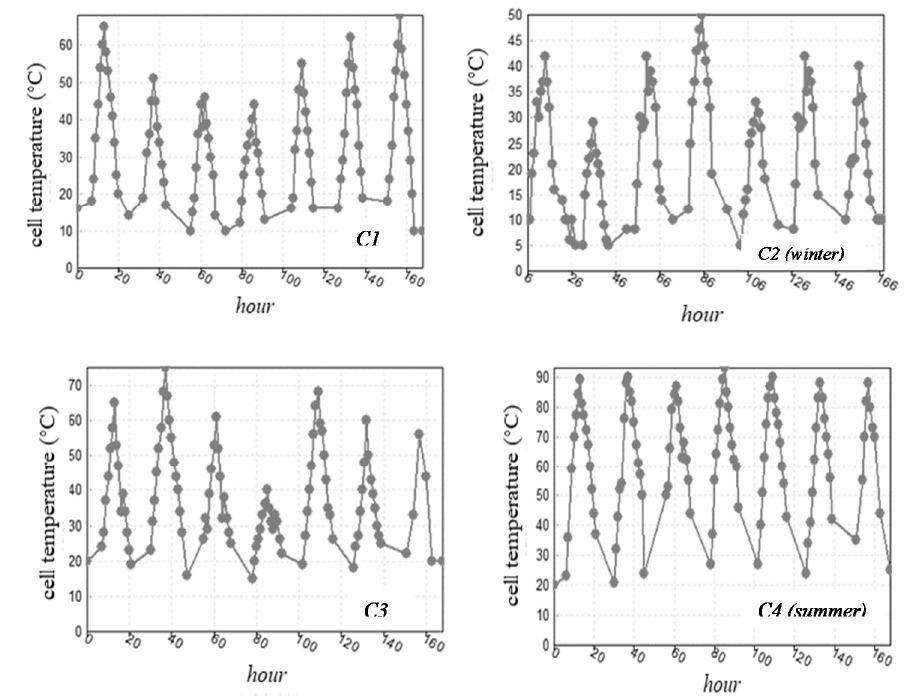
Figure 6. TJ cell temperature weekly distribution for the four clusters.